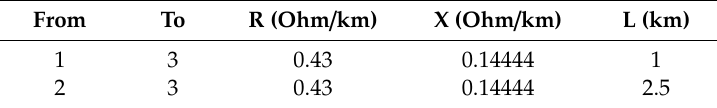
Table 2. Electrical features of the test system.